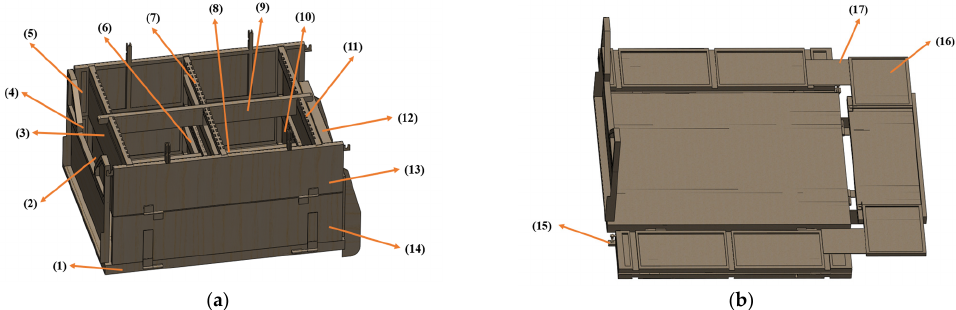
Figure 2. 3D models of loading box used for bee frame transportation ( a ) and beehive transportation ( b ). (1) Base panel and front panel, (2) front middle lower panel, (3) front middle upper panel, (4) right side lower panel, (5) right side upper panel, (6) middle lower panel, (7) middle upper panel, (8) lower cross baffle, (9) upper cross baffle, (10) rear middle lower panel, (11) rear middle upper panel, (12) rear baffle, (13) right side upper panel, (14) right side lower panel, (15) bolt fastening device, (16) auxiliary plate 1 of rear baffle, and (17) auxiliary plate 2 of rear